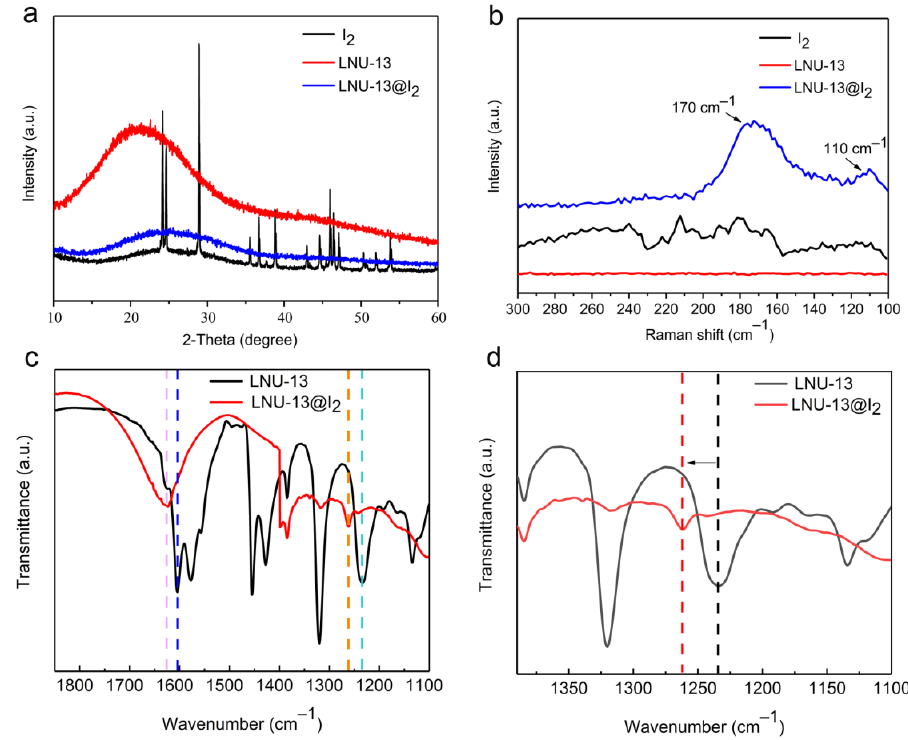
Figure 5. ( a ) PXRD spectra of I 2 , LNU-13, and LNU-13@I 2 ; ( b ) Raman spectra of I 2 , LNU-13, and LNU-13@I 2 ; ( c , d ) FTIR spectra of LNU-13 and LNU-13@I 2 . LNU-13@I 2 ; ( c , d ) FTIR spectra of LNU-13 and LNU-13@I 2